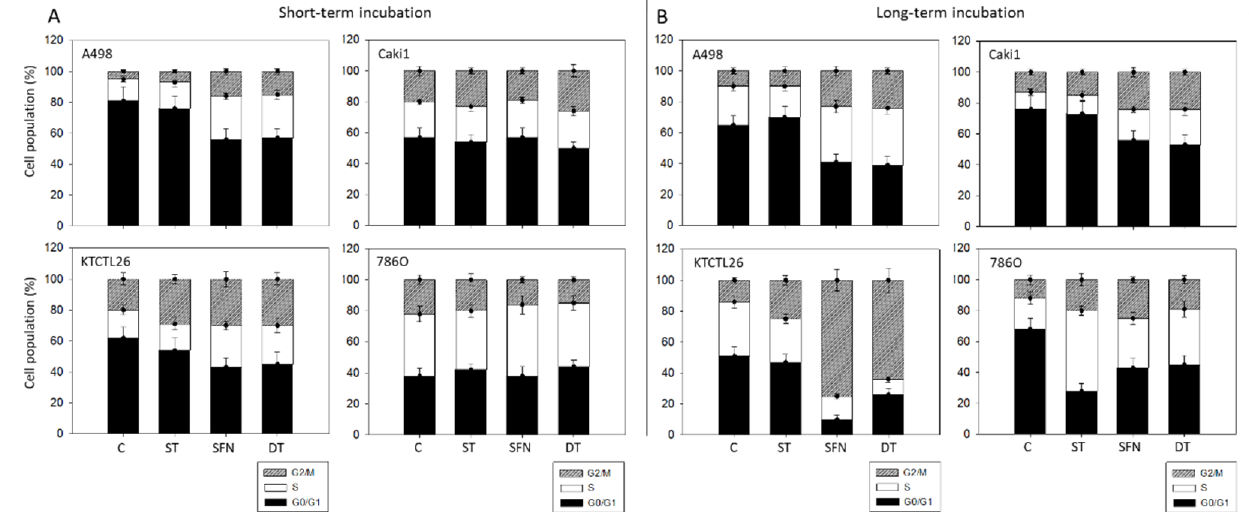
Figure 3. Influence of 1 μ M sunitinib (ST), 5 μ M sulforaphane (SFN), or both (DT) on proportionate G0/G1, S, and G2/M-phases of the cell cycle in A498, Caki1, KTCTL26, and 786O cells. ( A ) shows cells exposed short-term to the drugs, ( B ) shows cells pre-treated with the compounds for 8 weeks and subsequently re-exposed to the drugs (long-term incubation). Mean of n = 3 experiments.